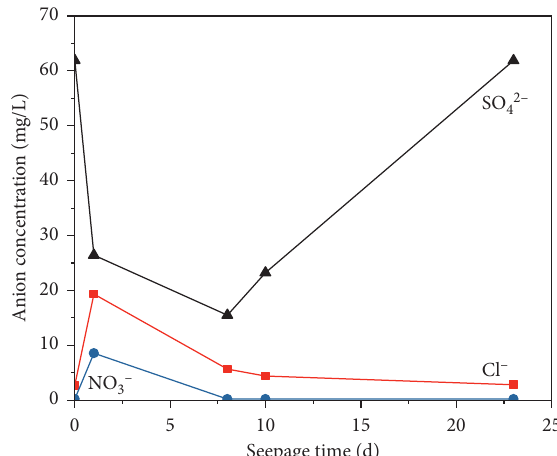
Figure 2: The concentration variation of main anions from the exudate in different periods.